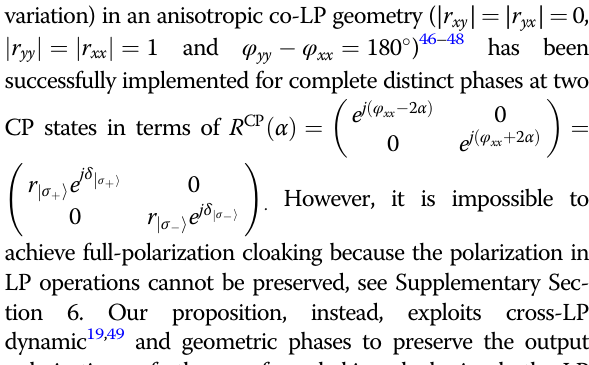
utilize the top circular I-shape resonator oriented along α = 45 o to break the symmetry along x and y axes and thus to generate two chirality-assisted characteristic modes ( A k and A ? ), with major electric- fi eld distribution parallel and perpendicular to principal axis under SOP of σ x j i and